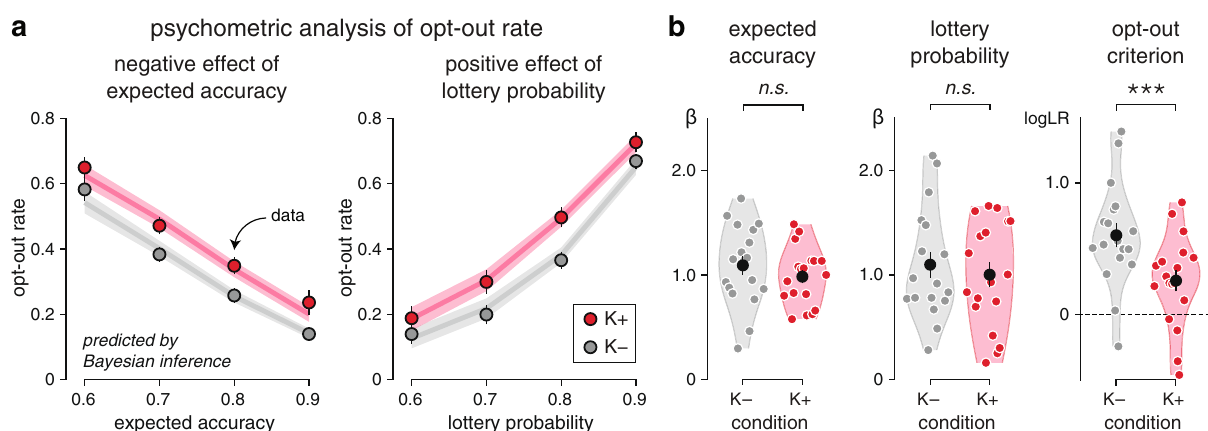
Fig. 2 Increased decision uncertainty under ketamine. a Psychometric analysis of opt-out rate. Effects of expected accuracy (left) and lottery probability (right) on opt-out rate. Dots indicate observations (group-level means±s.e.m.), whereas lines indicate best fi ts. Psychometric curves show a clear upward shift under ketamine. b Best- fi tting psychometric parameters (left: sensitivity to expected accuracy; middle: sensitivity to lottery probability; right: opt-out criterion). Participants are equally sensitive to expected accuracy and lottery probability between conditions, but show a lower opt-out criterion under ketamine. Black dots and error bars indicate group-level means±s.e.m., whereas colored dots indicate participant-level data. Three stars indicate a signi fi cant effect at p <0.001, n.s . a non-signi fi cant effect ( N = 18 participants, uncorrected two-sided t tests). Source data are provided as a Source Data fi